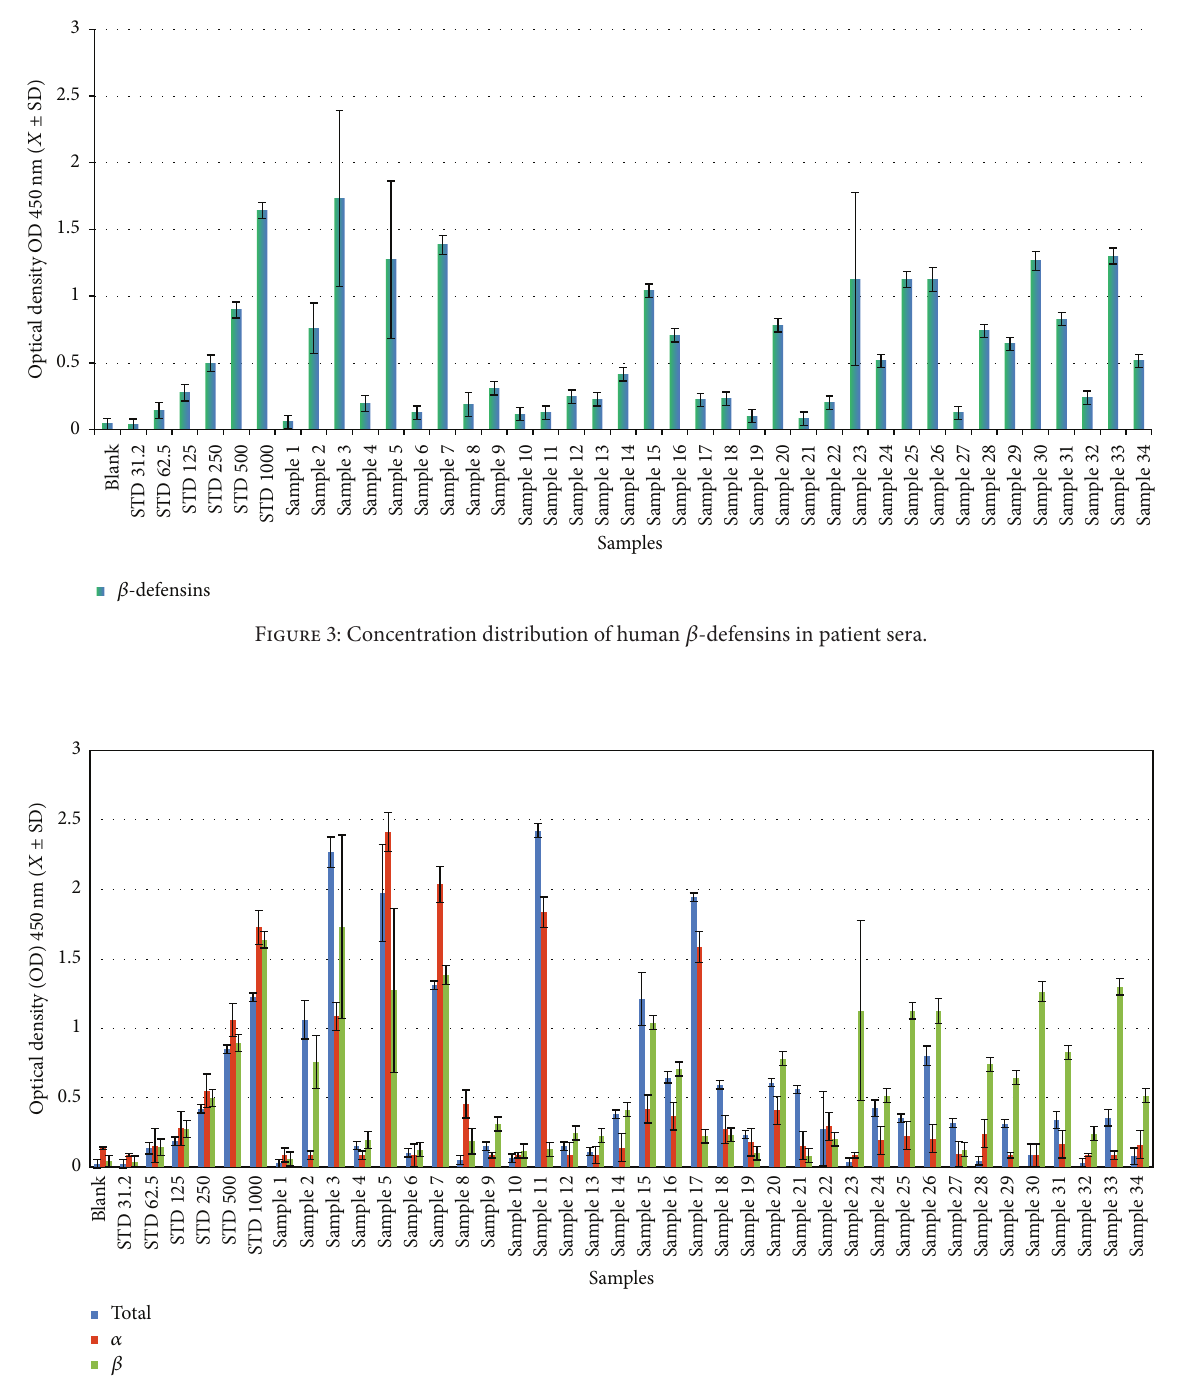
50% of the patients showed 𝛽 -defensin concentrations of > 250 ng/50 𝜇 L, ranging from 258 to 1056 ng/50 𝜇 L (Figures 3 and 4 and Tables 3 and 4). The concentrations of 𝛽 - defensins in both male ( 302.01±280.69 ng/50 𝜇 L) and female ( 370.7 ± 323.8 ng/50 𝜇 L) patients were similar (Figures 3 and 4 and Tables 3 and 4). Concentrations of 𝛽 -defensins